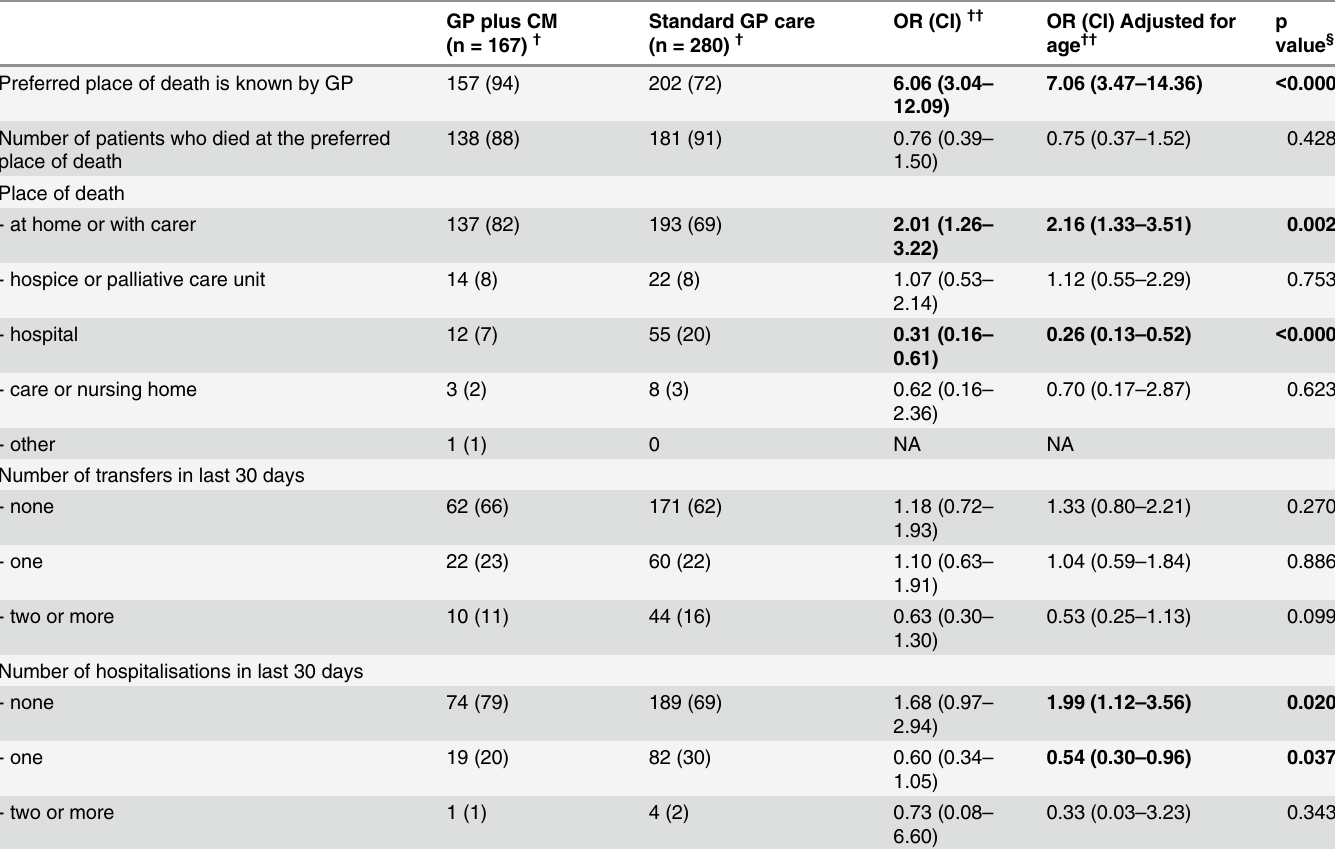
Table 3. Preferred place of death, place of death, and number of transfers and hospitalisations of cancer patients with additional support from a case manager and patients receiving standard GP care. GP plus CM (n = 167)